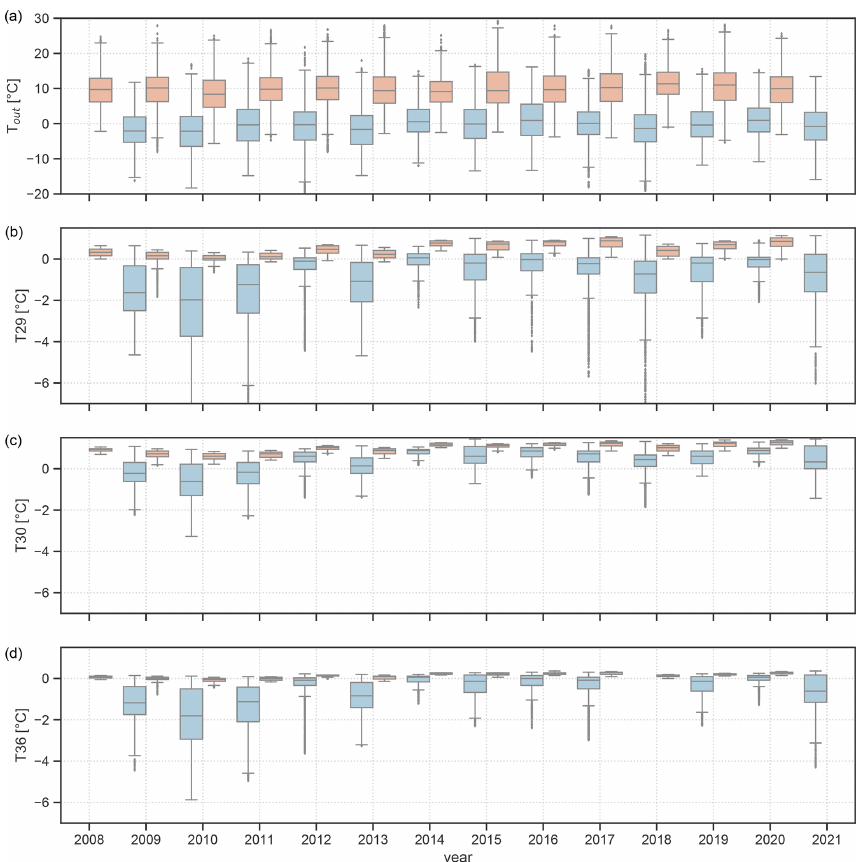
Figure 4. Seasonal temperature for the measuring period of June 2008 to March 2021 outside the cave (a) and the three long-term loggers inside the cave for the summer (May to October) and winter (November to April) half-year in orange and blue, respectively. The boxes mark the interquartile range (IQR) and whiskers the distance of 1.5 times the IQR. No box is plotted for a season with more than 2 months of missing data at the respective